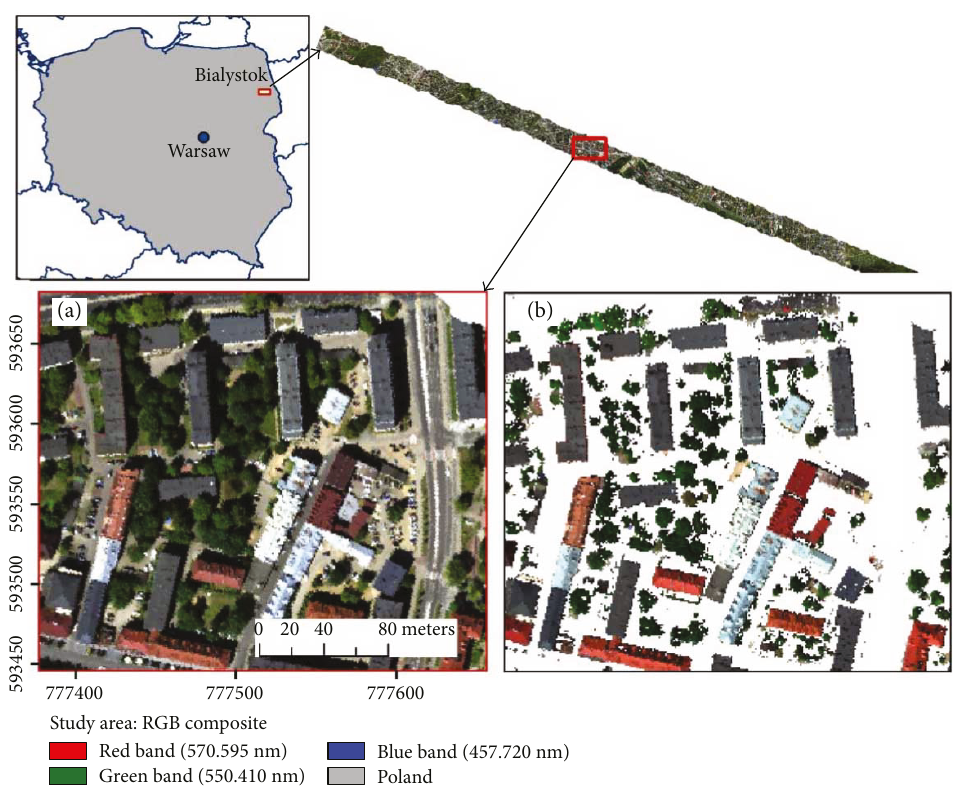
Figure 1: Study area: (a) RGB composite and (b) masked for shadows and a LiDAR mask below 2.5